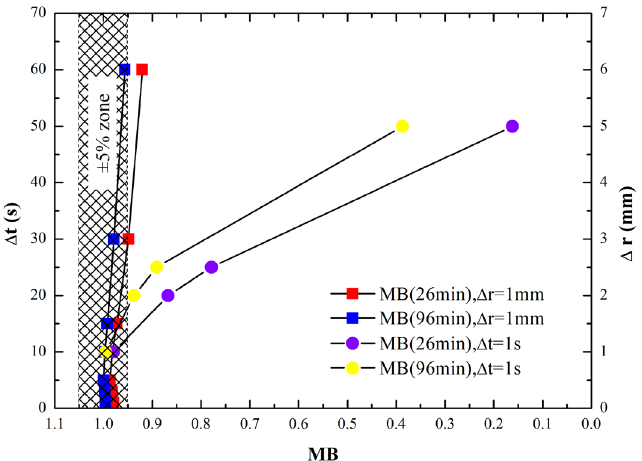
Figure 8. Mass balance performance of the numerical model in Case 1. Results indicated with rectangles are calculated with △ r = 1 mm and △ t varied from 1 to 60 s, and results indicated by circles are calculated with △ t = 1 s and △ r varied from 1 to 5 mm.